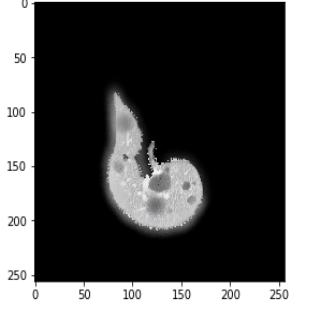
Figure 5. Mask image for tumor detection.